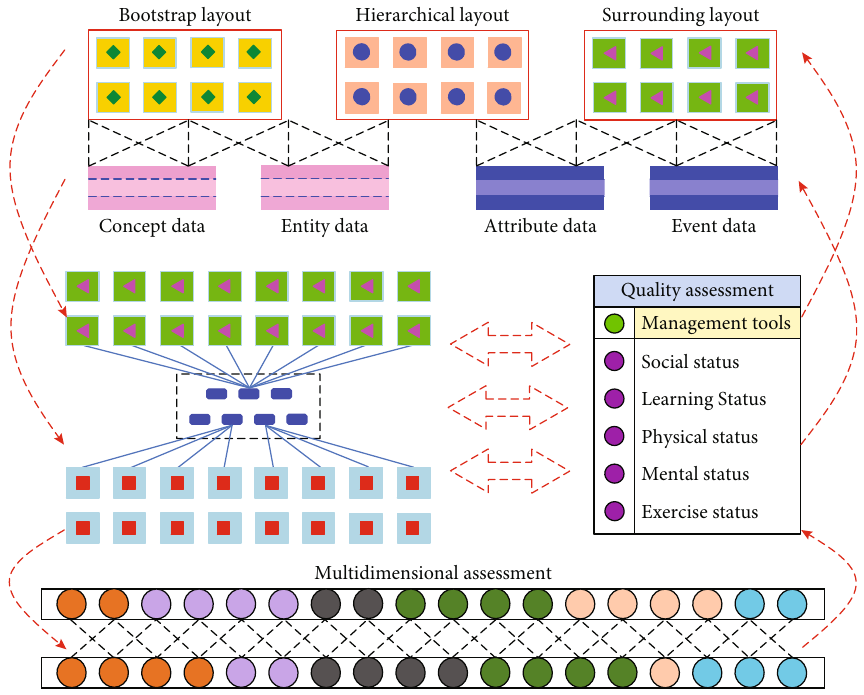
Figure 1: Multidimensional assessment model physical exercise and psychological changes of college students before and after the intervention based on multidimensional data mining.